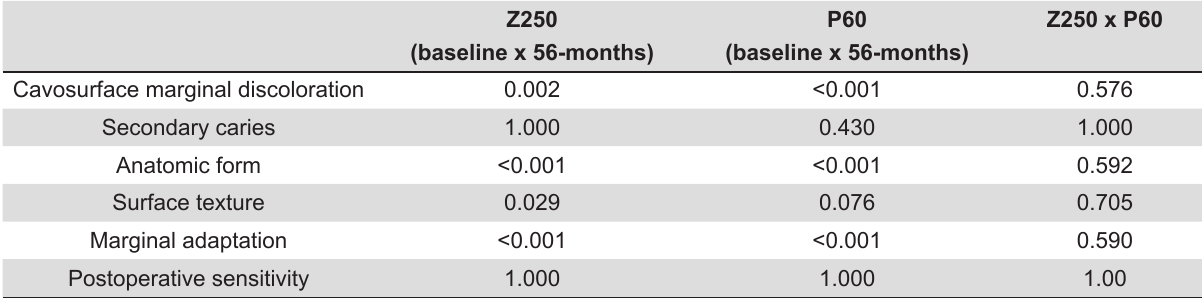
Table 3- Statistical values of the comparisons between the performances of the